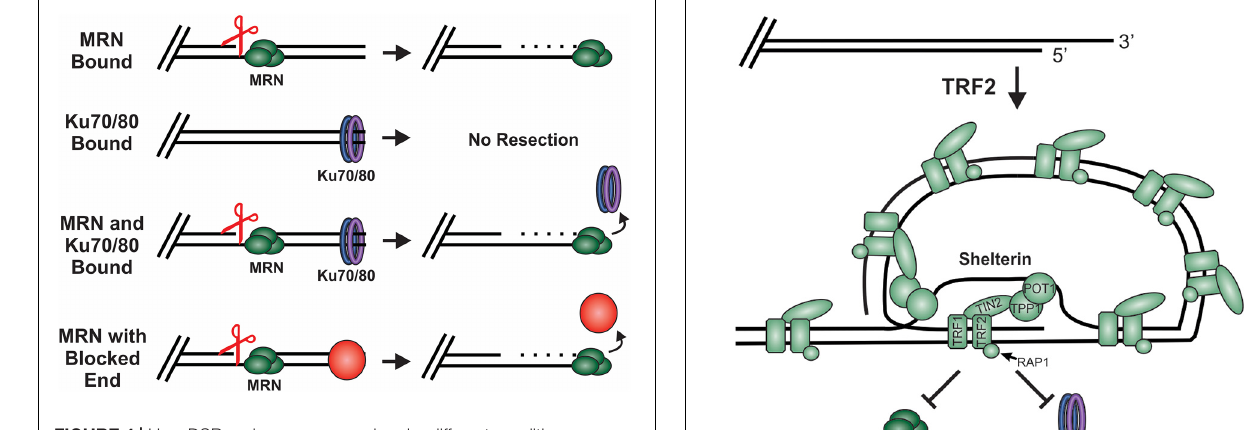
(EXO1) (Zhou and Paull, 2013). This allows the recruitment of EXO1 to DNA ends to promote HR rather than NHEJ, through mechanisms that are still poorly